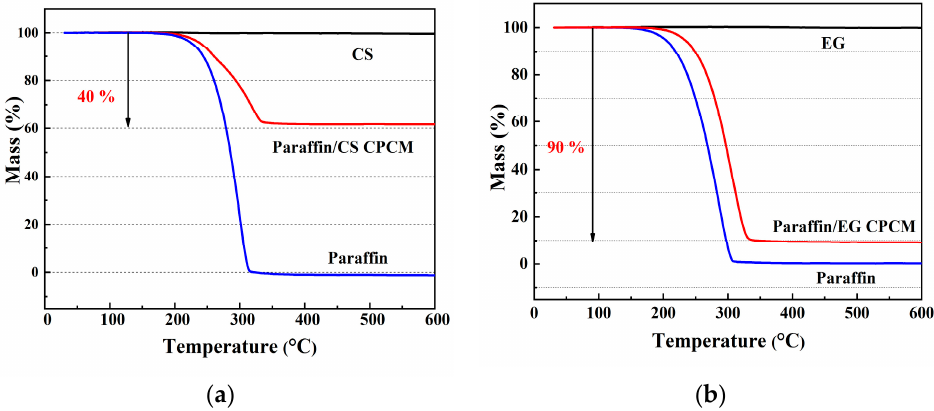
Figure 5. Thermogravimetric (TG) curves of samples: ( a ) paraffin/CS; ( b ) paraffin/EG.